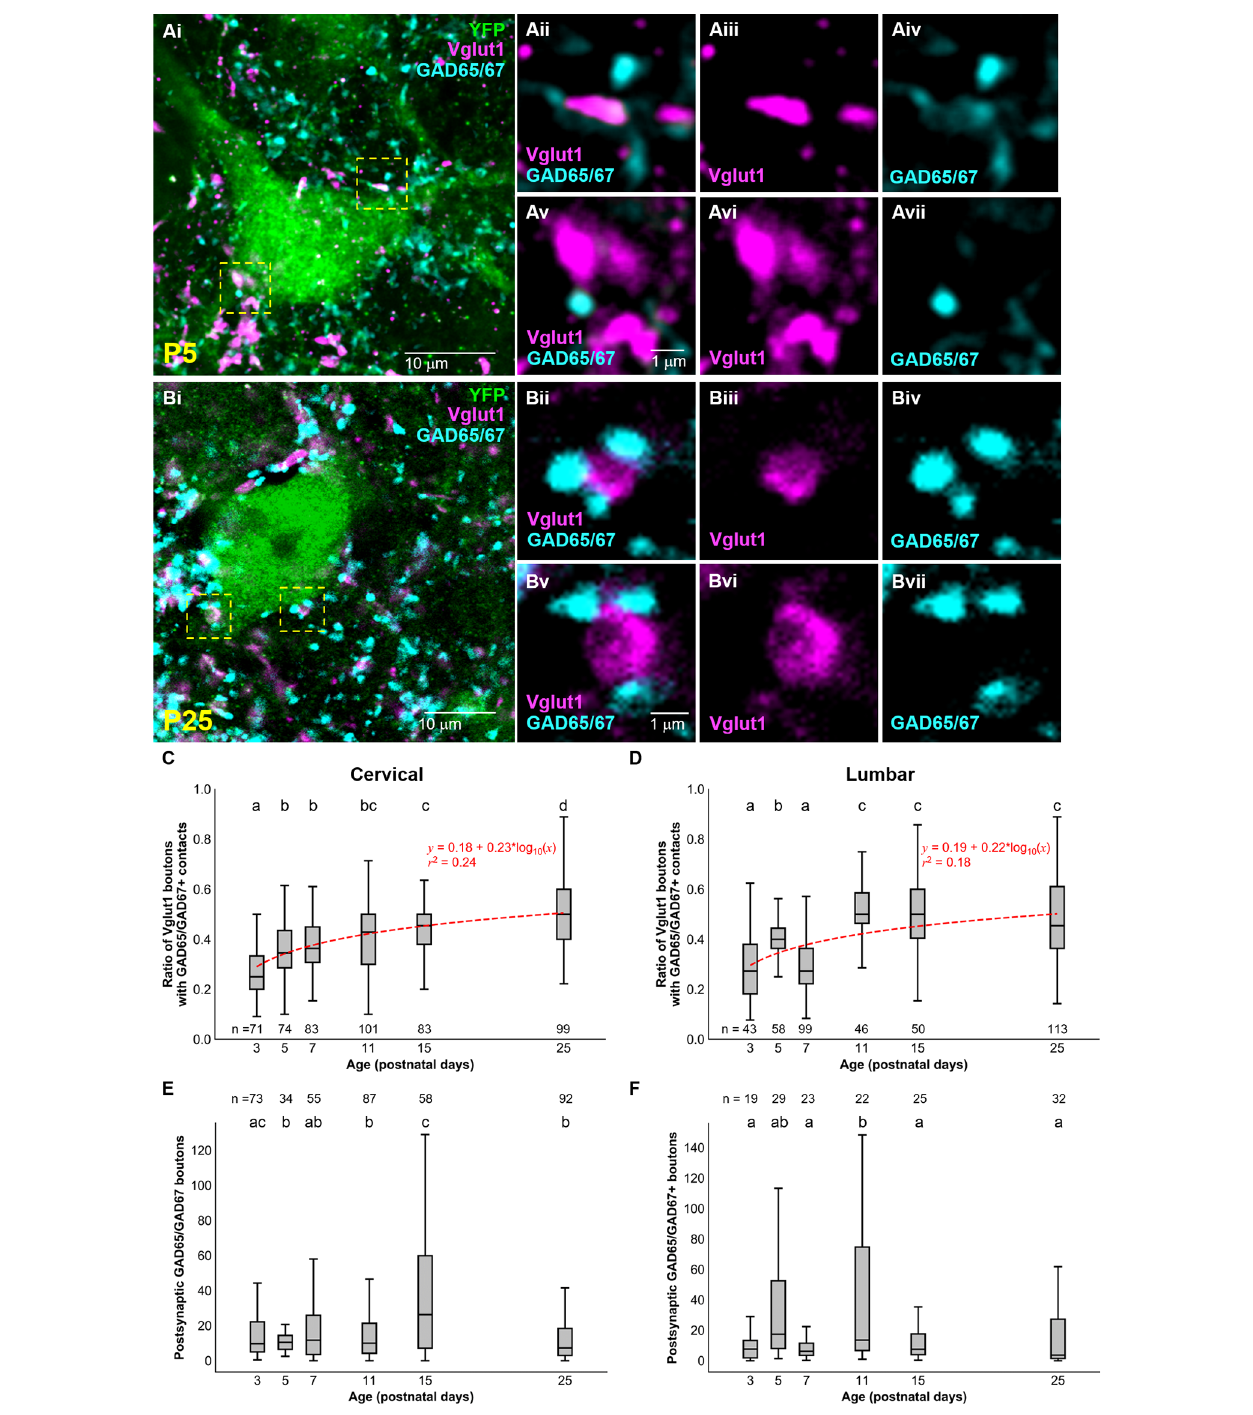
FIGURE 3 | Development of GAD65/67+ boutons on Vglut1+ inputs to dI3 INs. GAD65/67+ boutons contacting Vglut1+ terminals on cervical YFP+ dI3 IN from a (A) P5 and (B) P25 spinal cord. Boutons in yellow dashed boxes are magnified in Aii-Avii and Bii-Bvii. (C) The ratio of Vglut1+ boutons with GAD65/67+ contacts on cervical dI3 INs and (D) lumbar dI3 INs at time points between P3 and P25. (E) The number of postsynaptic GAD65/67+ boutons per cell on cervical dI3 INs and (F) lumbar dI3 INs at time points between P3 and P25. The sample sizes in (E,F) refer to the number of images analyzed. A comparison of the means was made using a one-factor ANOVA. Pairs of groups sharing a letter are not statistically different at the p < 0.05 level according to Tukey’s post-hoc Test. For example, the means of two groups with the letter “a” are not pairwise statistically different. Curve fitting was performed using nonlinear regressions with semilog lines. The 95% confidence intervals for the slopes of (C,D) are [0.20, 0.27] and [0.18, 0.27], respectively. The 95% confidence intervals for the y -intercept of (C,D) are [0.14, 0.22] and [0.14, 0.23], respectively.